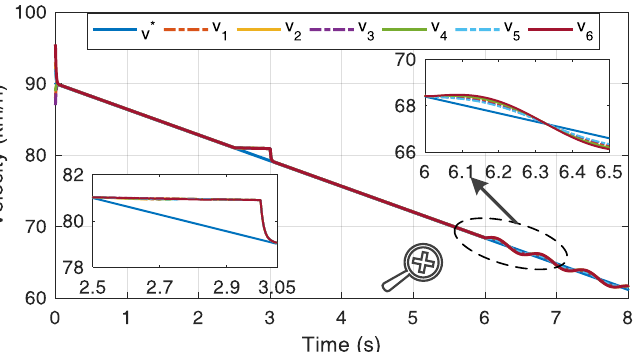
Figure 11. Velocity curve of each carriage without the anti-disturbance control component in case 3.